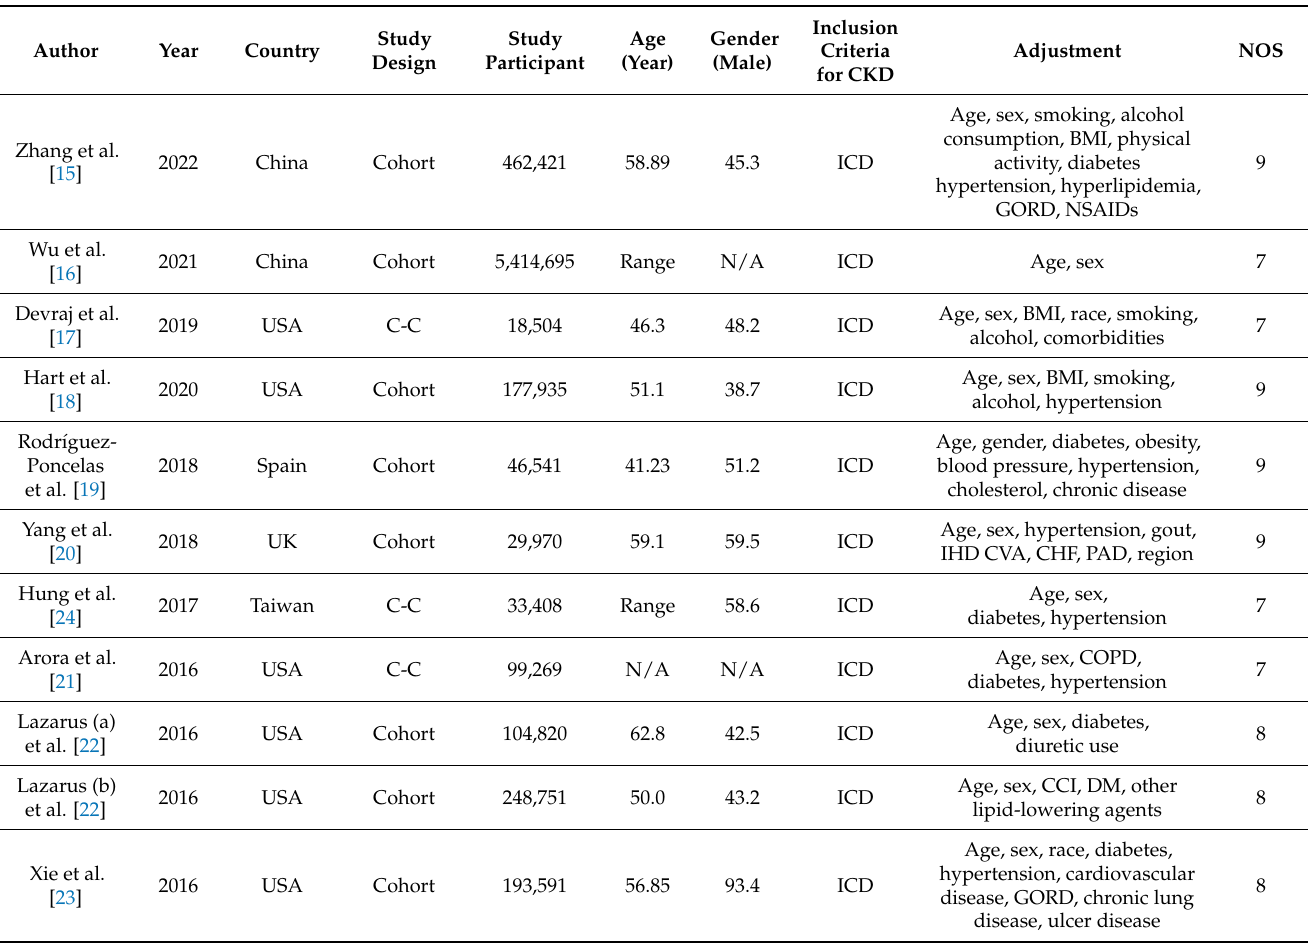
Table 1. Shows the basic characteristics of studies included to evaluate the association between PPI and